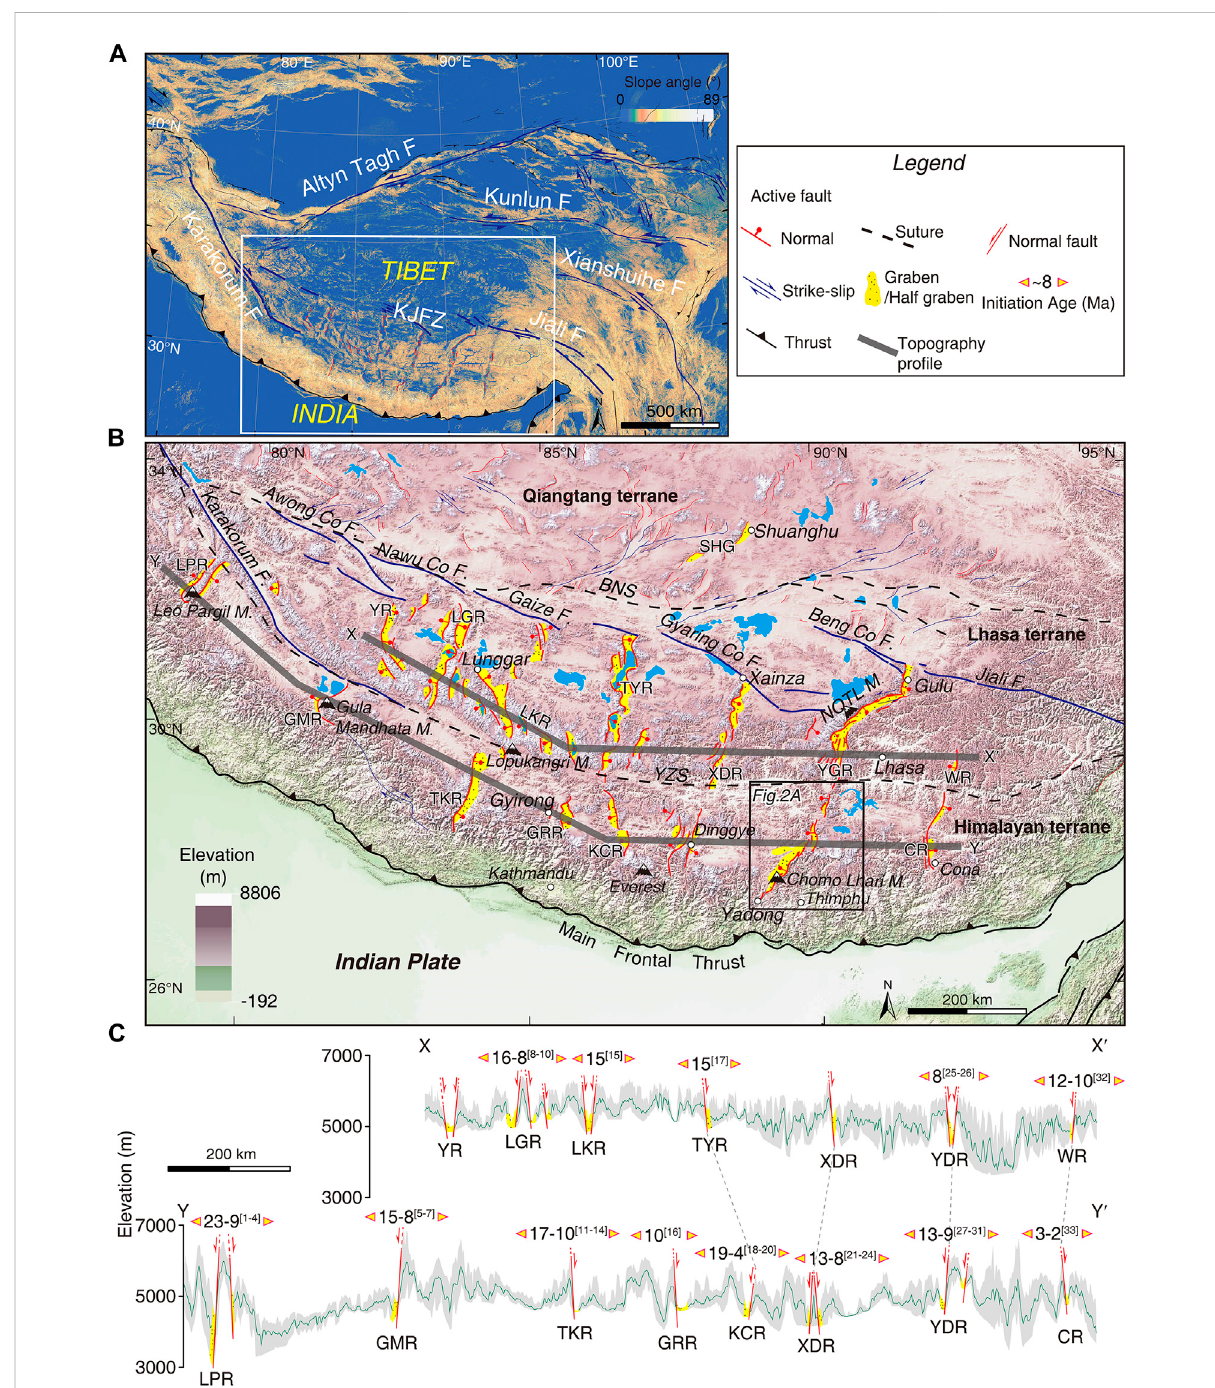
FIGURE 1 (A) Slope map and main active faults of Tibetan Plateau. (B) Active faults of Tibetan Plateau interior with main rifts, modi fi ed from Tapponnier et al. (2001) and Chevalier et al. (2020) (C) Topographic pro fi les across the south Tibetan rifts with initiation ages in Ma (references as in Supplementary Table S1). Main rifts and sutures are: CR, Cona rift; GMR, Gurla Mandhata rift; GRR, Gyirong rift; KCR, Kung Co rift; LGR, Lunggar rift; LPR, Leo Pargil rift; SHG, Shuanghu graben; TKR, Thakkhola rift; TYR, Tangra Yumco rift; WR, Woka rift; XDR, Xainza-Dinggye rift;YGR,